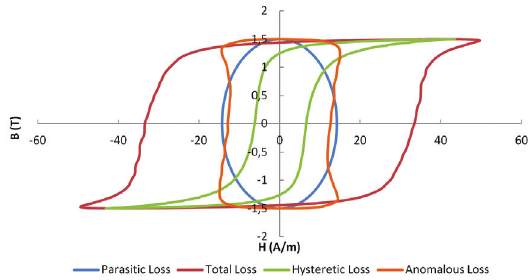
Figure 6. Loss separation for GO samples using peak induction 1.5 T and frequency 100